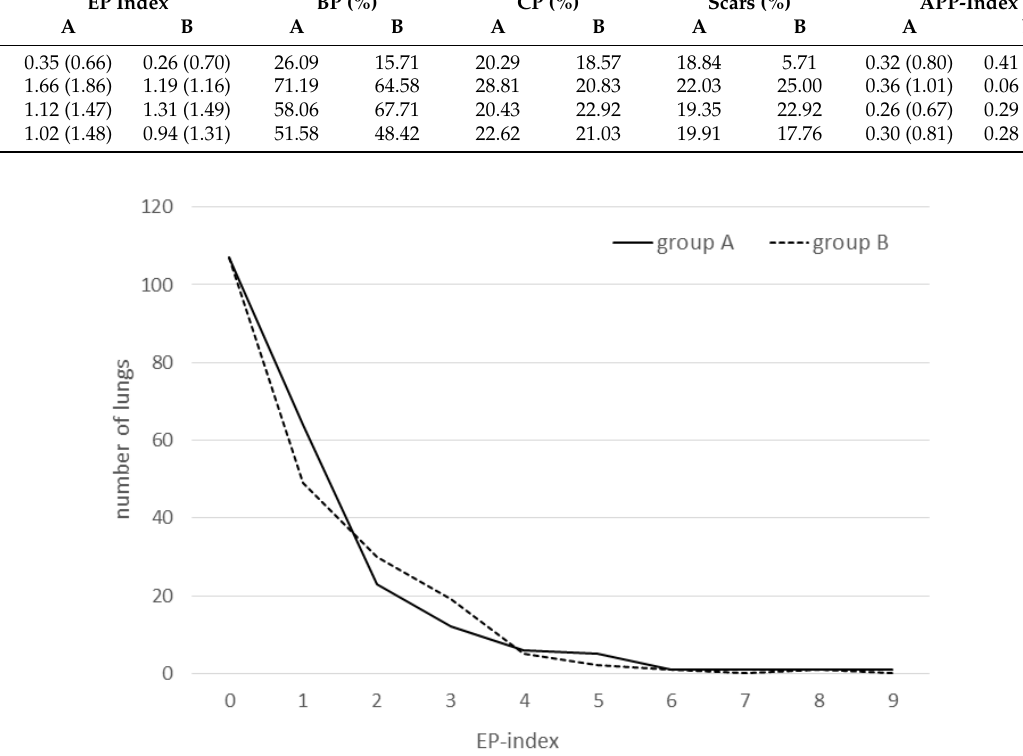
Figure 1. Distribution of EP index values over all three consecutive fattening cohorts in group A (IM vaccine, n = 221) and group B (ID vaccine, n = 214).